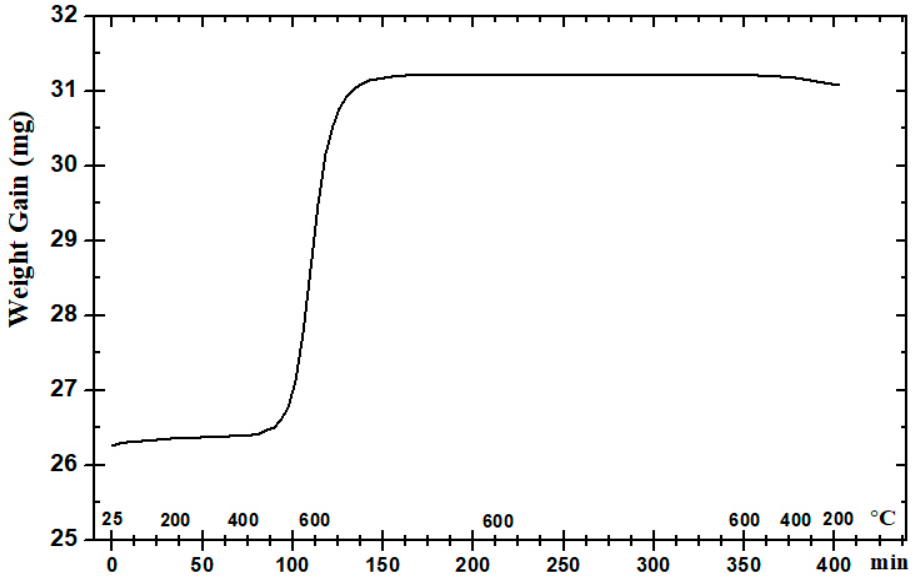
Figure 8. TGA results showing WC weight gain versus time up to a temperature of 600 °C.